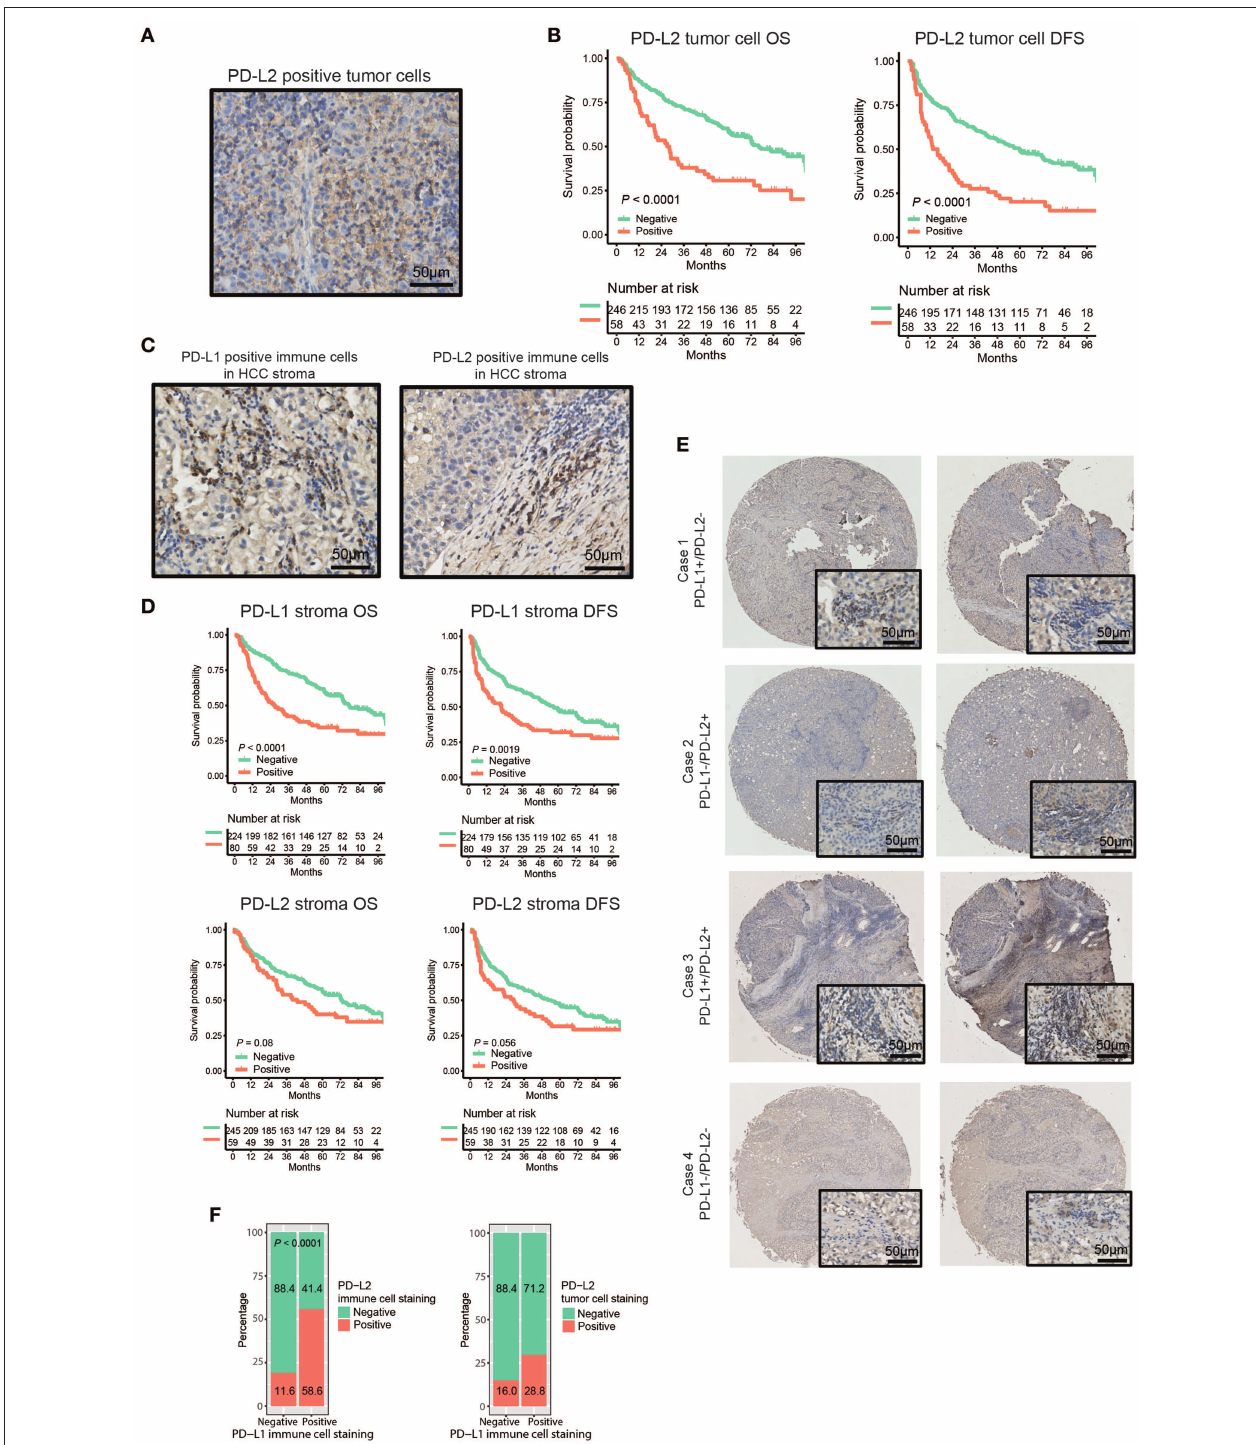
FIGURE 1 | Distribution and expression of PD-Ls and their correlation with prognosis in HCC patients. (A) IHC staining of PD-L2 on tumor cell membrane. (B) Kaplan-Meier curve of OS and DFS stratified by PD-L2 expression on tumor cell membrane. (C) IHC staining of PD-L1 and PD-L2 in immune stromal cells. (D) Kaplan-Meier curve of OS and DFS stratified by PD-L1, PD-L2 expression in immune stroma. (E) Representative images showing the association between expression of PD-L1 and PD-L2 in immune stroma. (F) Proportions of HCC tumor samples expressing PD-L2 in immune stroma (left panel) and on tumor cell membranes (right panel) stratified by PD-L1 expression in immune